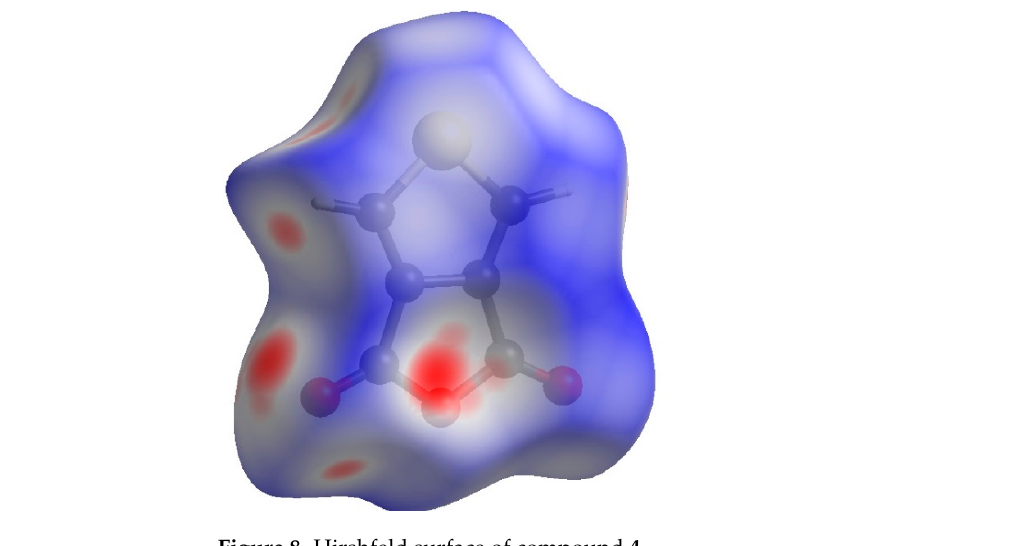
Figure 8. Hirshfeld surface of compound 4 .